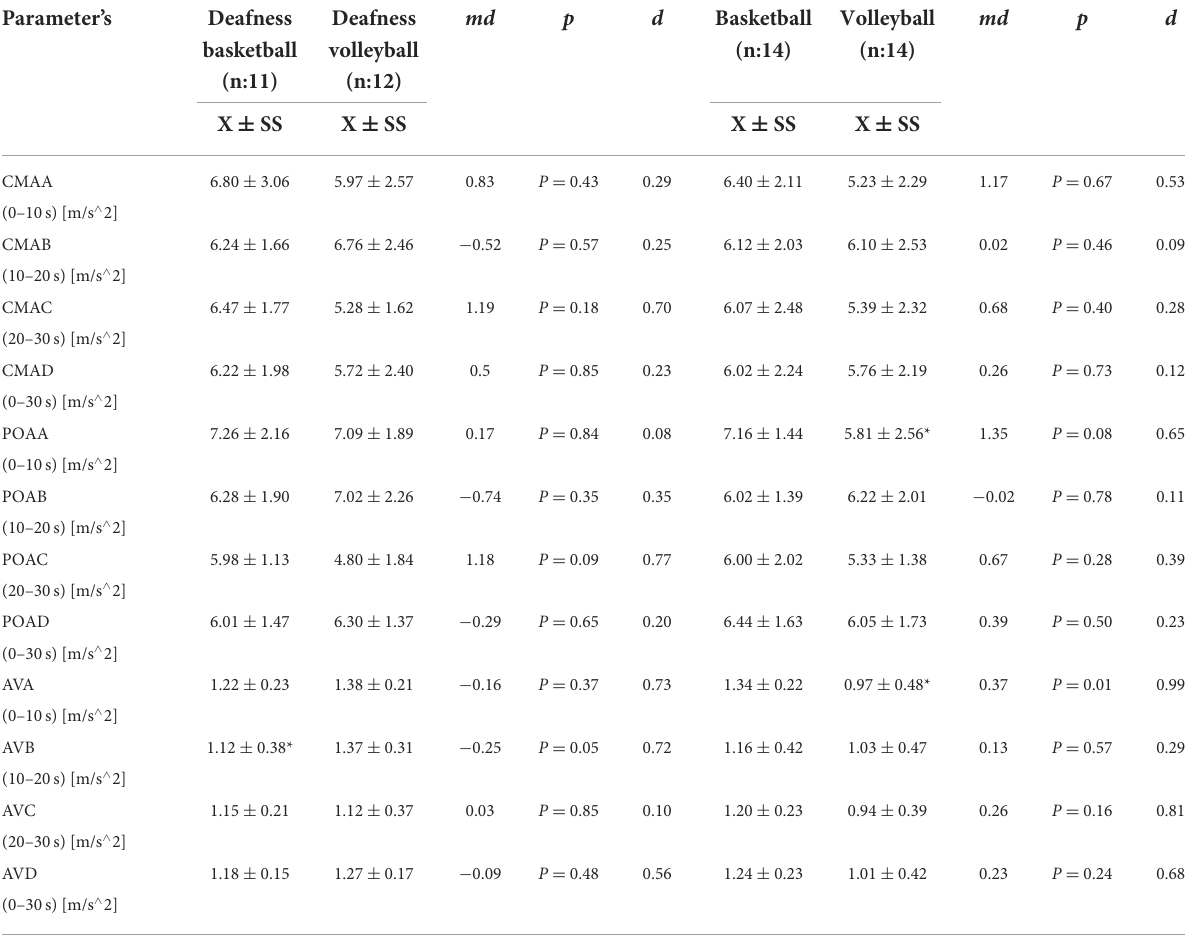
TABLE 5 Comparison of counter movement acceleration, push off acceleration and average velocity of deaf basketball/volleyball and non-deaf basketball/volleyball players. md Basketball Volleyball Parameter’s Deafness Deafness basketball volleyball (n:11) (n:12)